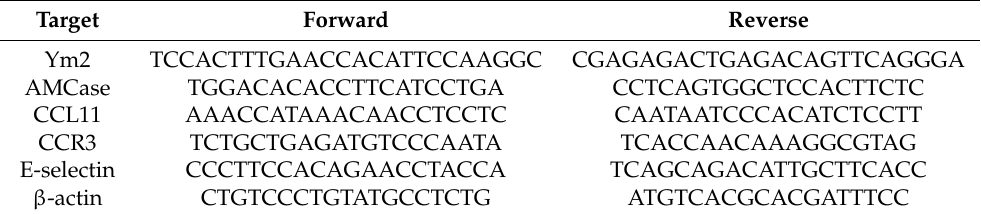
Table 1. Primer sets for reverse transcription-polymerase chain reaction